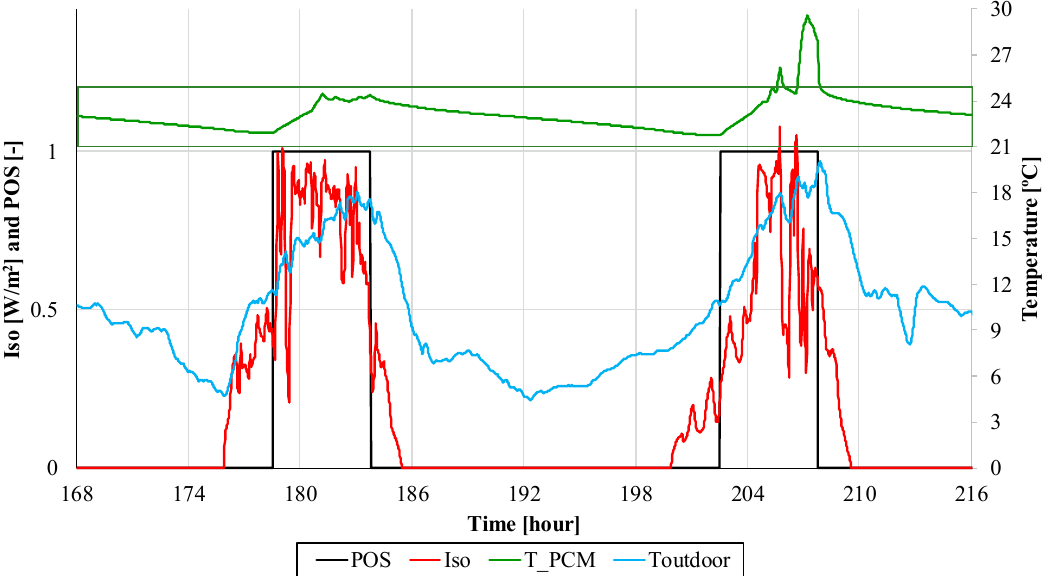
Figure 4. Evolution of PCM temperature in dynamic system when implemented in the ASHRAE (Wall 2) envelope.